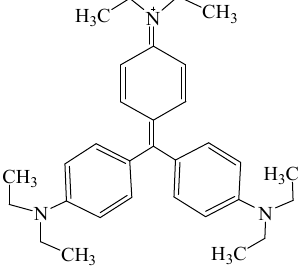
Figure 1. The chemical structure of cationic ethyl violet dye.